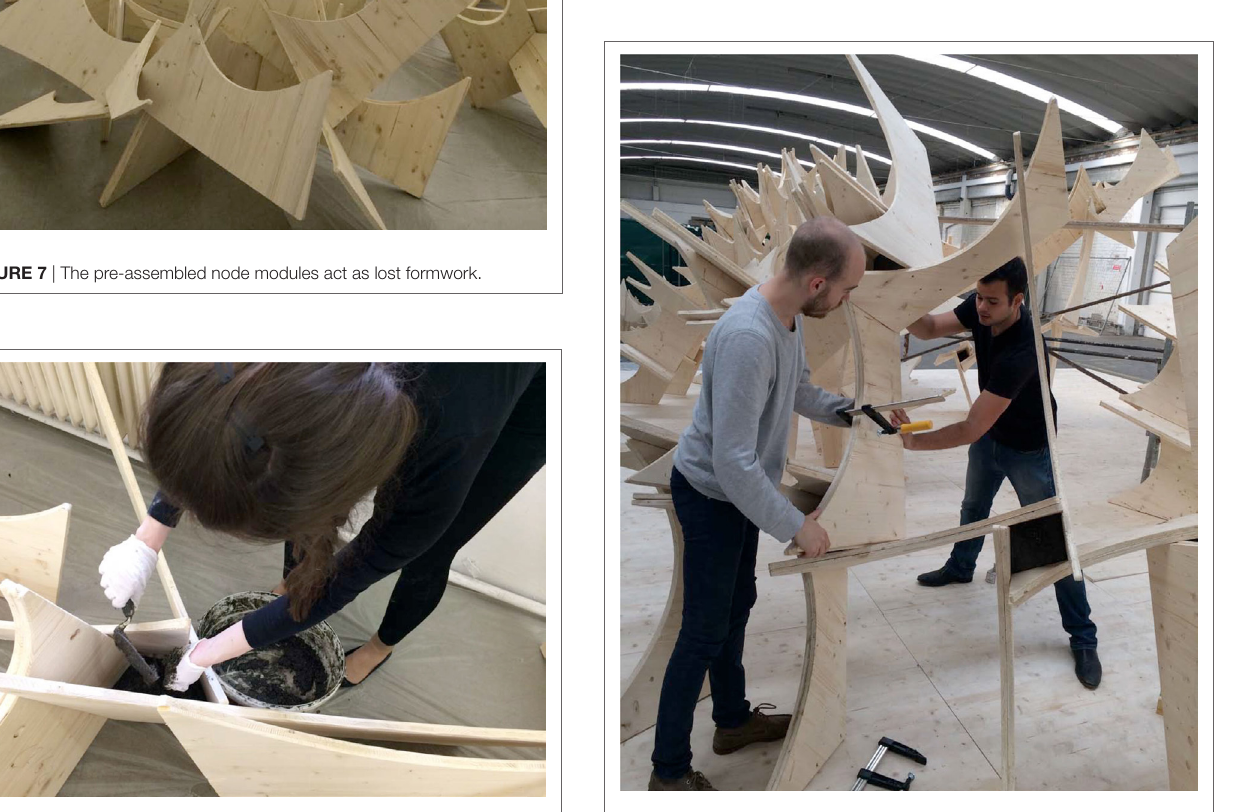
FIgURe 10 | Pavilion assembly by bolting the modules to double